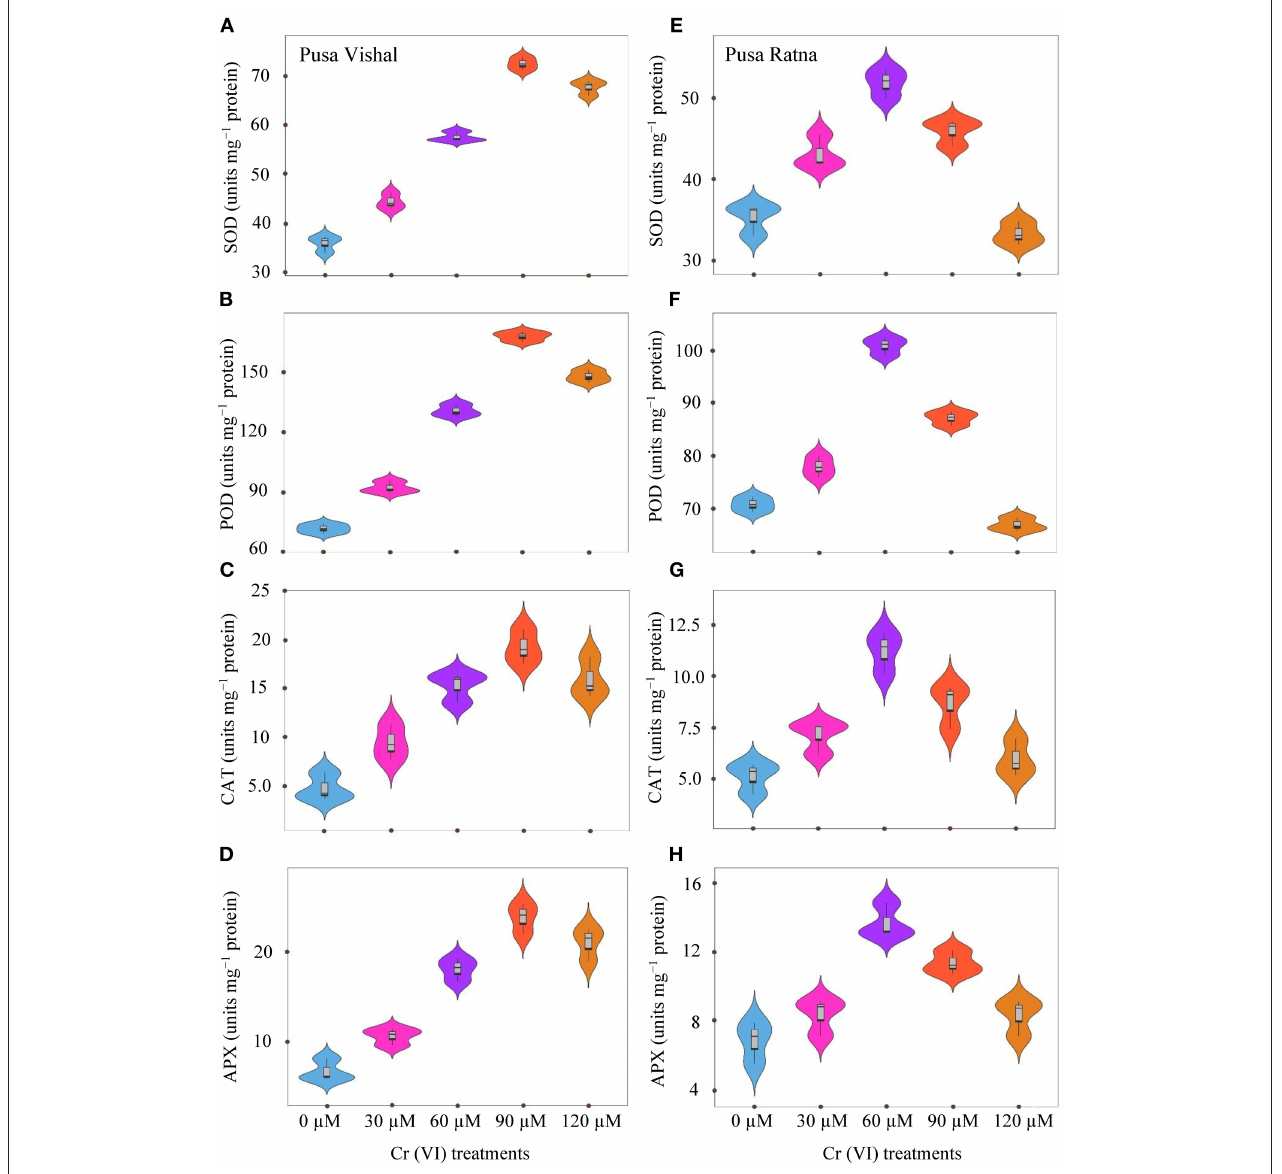
FIGURE 5 | Violin plots screening the distribution of values for superoxide dismutase (SOD) (A,E) , ascorbate peroxidase (APX) (D,H) , peroxidase (POD) (B,F) , and catalase (CAT) (C,G) , in leaves of Pusa Vishal (PV) and Pusa Ratna (PR) cultivars grown in hydroponic conditions with different Cr (VI)